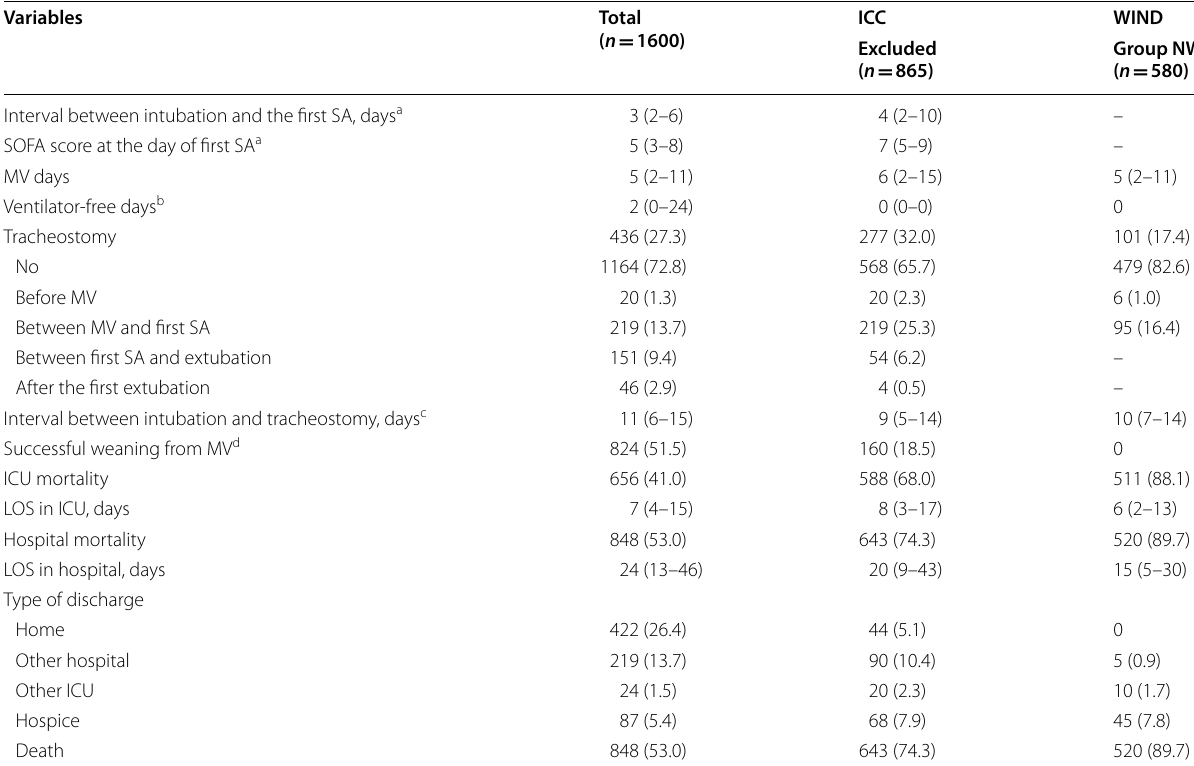
Table 4 Clinical outcomes of total cohort, excluded patients by ICC classification, and Group NW by WIND classification